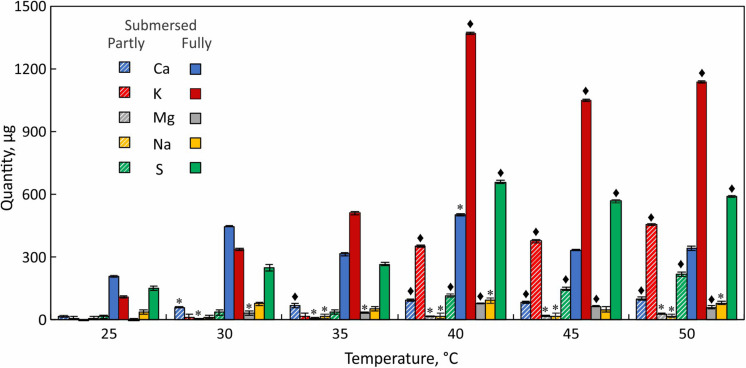
Elemental analysis of leachate from partially (hatched bars) and fully submersed (solid bars) Pleopeltis fronds. Significant differences between heat treated and 25°C control are indicated by * (P ≤ 0.05) and ◆ (P ≤ 0.001); means ± SE, n = 3.